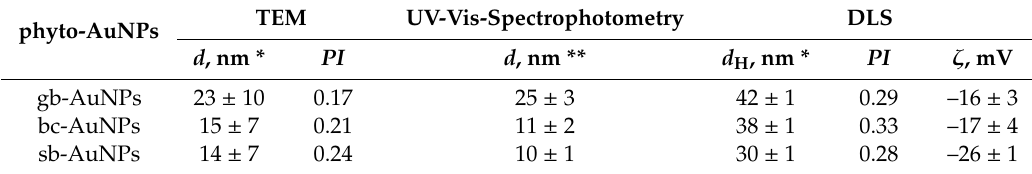
Table 3. Characteristics of phyto-AuNPs by TEM and phyto-AuNPs suspensions obtained by UV-Vis spectrophotometry and DLS. (Synthesis conditions: 5 mL of 1 mM HAuCl 4 + 1 mL of leaf extract, time 300 s). The results are presented as X ± ∆ X , where X is the average value and ∆ X is the standard deviation.